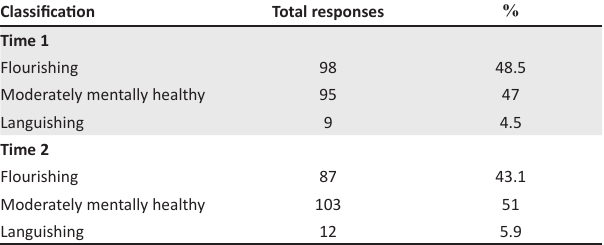
TABLE 5: Prevalence of workplace flourishing across time points ( N = 202). Classification